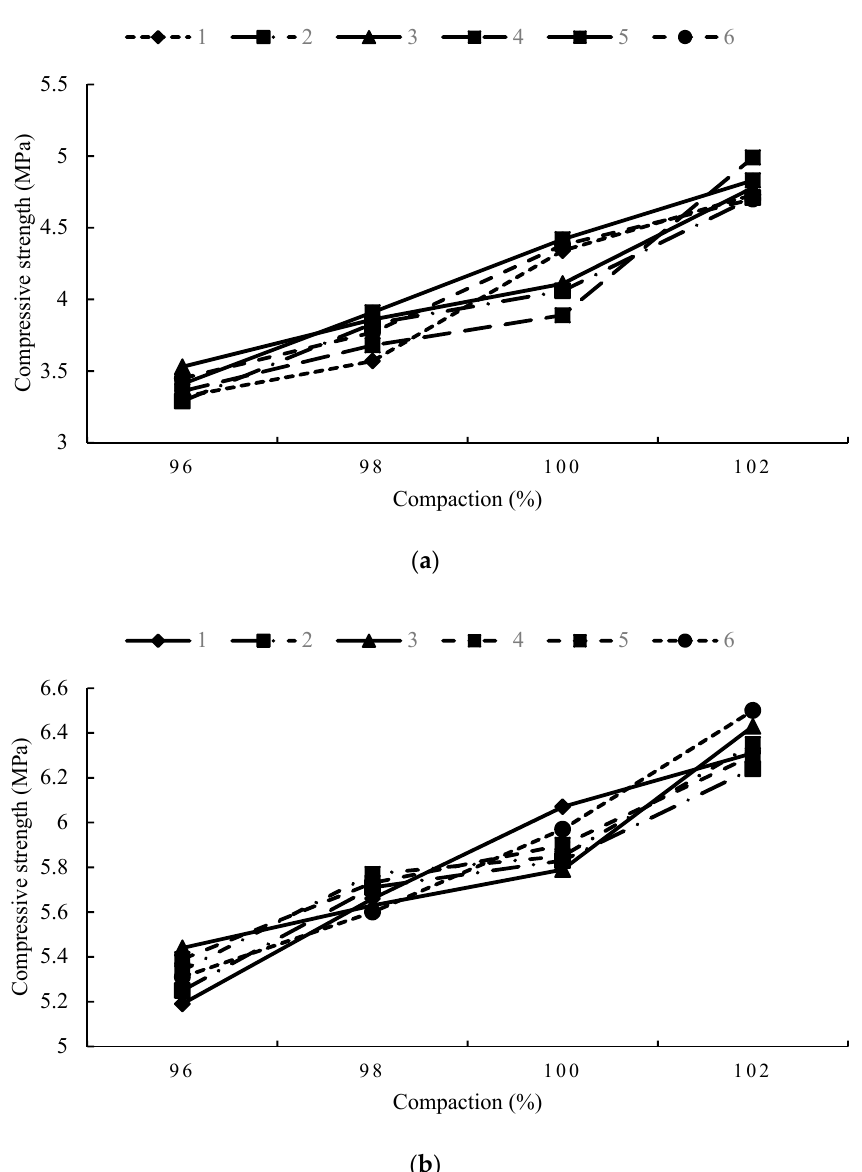
Figure 1. Compressive strength under different test procedures: ( a ) The relationship between compaction and compressive strength after 7 days of curing; ( b ) the relationship between compaction and compressive strength after 28 days of curing.